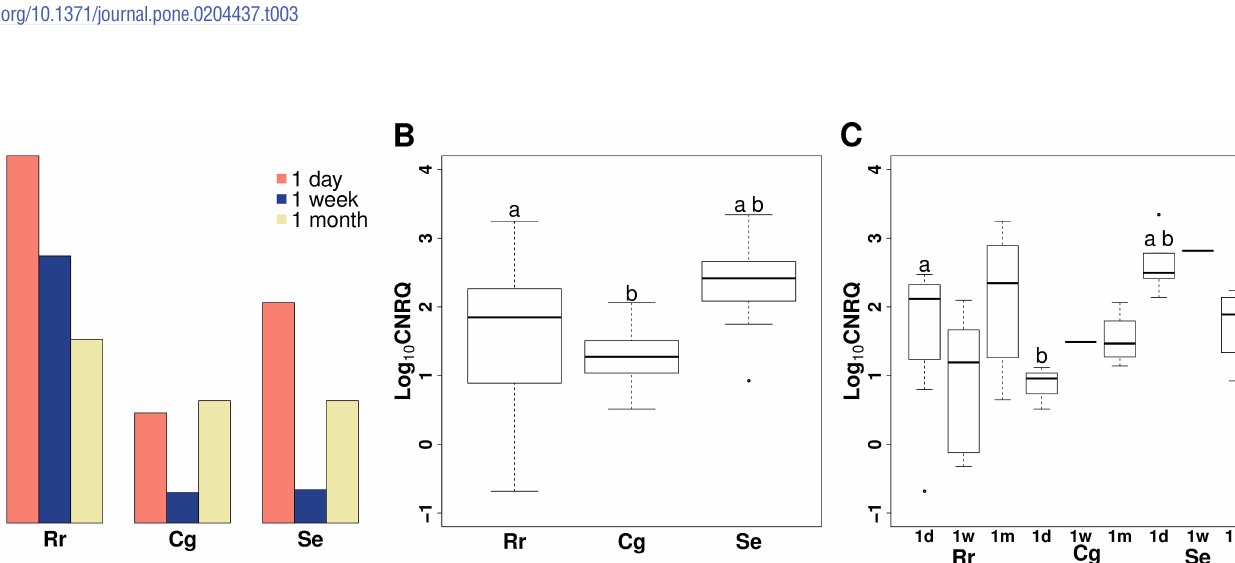
PLOS ONE | https://doi.org/10.1371/journal.pone.0204437 September 21,